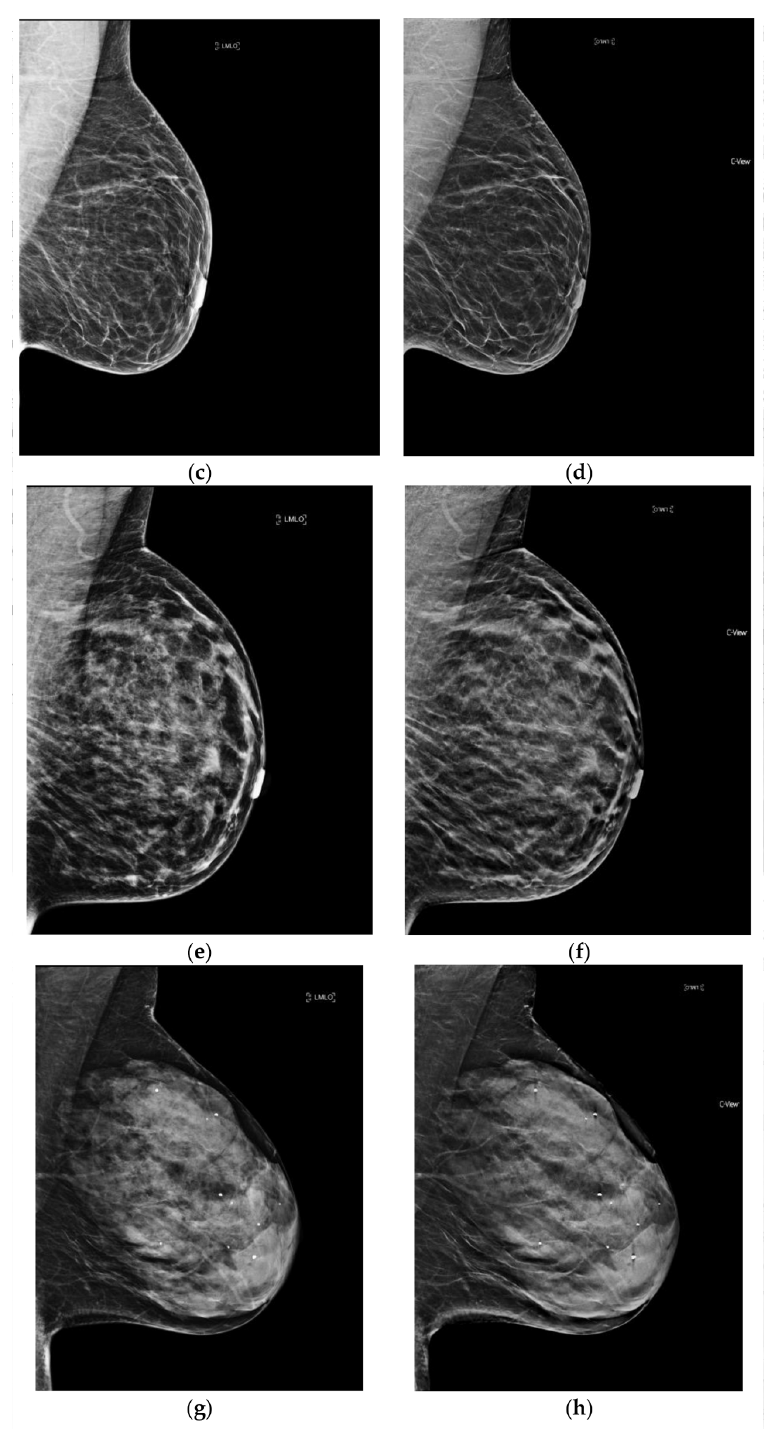
Figure 1. The four categories of breast density on conventional 2D FFDM and synthesized mammography. ( a ) Predominantly fatty breast 2D FFDM ( b ) Predominantly fatty breast s2D FFDM ( c ) Scattered fibroglandular breast 2D FFDM ( d ) Scattered fibroglandular breast s2D ( e ) Heterogeneously dense breast 2D FFDM ( f ) Heterogeneously dense breast s2D ( g ) Extremely dense breast 2D FFDM ( h ) Extremely dense breast